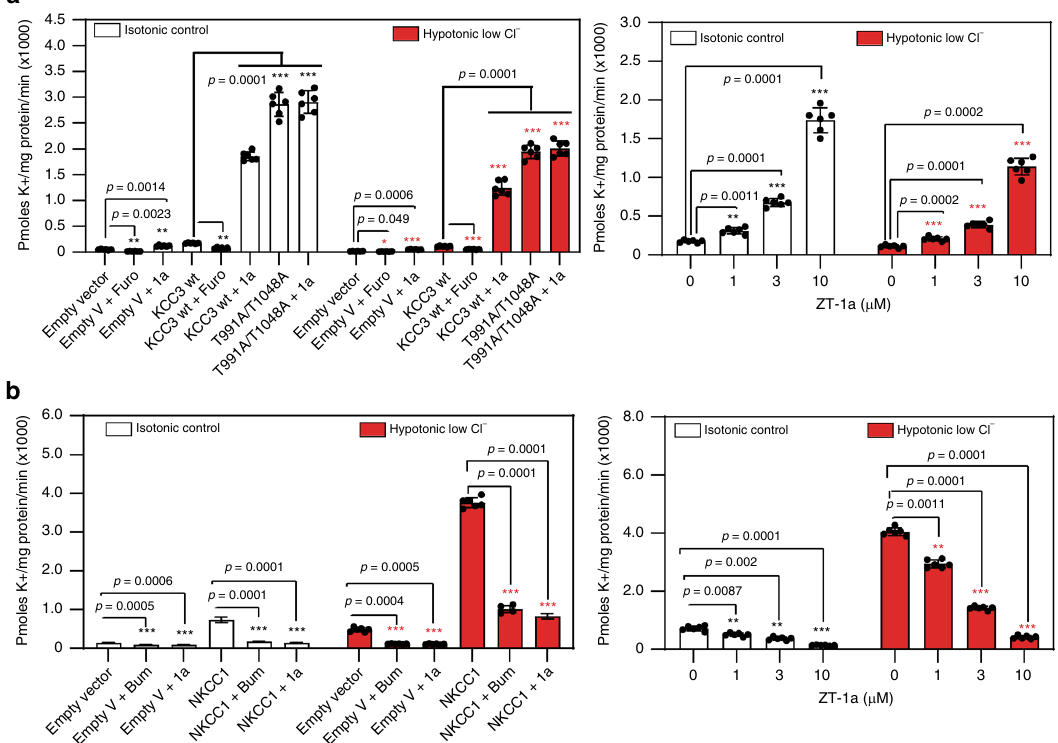
Fig. 3 ZT-1a inhibition of SPAK kinase correlates with CCC activity. a 86 Rb + uptake assays in the presence of ZT-1a measure transport activity of KCC3A. ( a — left panel) HEK-293 cells were transfected with constructs encoding the indicated WT or mutant constructs of N-terminally FLAG-tagged KCC3. Thirty-six hours post transfection, cells were exposed for 30 min to either control isotonic conditions or hypotonic low [Cl − ] conditions (to activate the SPAK/OSR1 pathway), and then treated in the same conditions for an additional 30 min with 10 µ M ZT-1a or 1 mM furosemide (Furo) in the presence of 1 mM ouabain (Na + /K + -ATPase inhibitor) and 0.1 mM bumetanide (NKCC1 inhibitor). 86 Rb + uptake was allowed to proceed for 10 min and was then quanti fi ed by scintillation counting. 86 Rb + uptake counts per minute (CPM)s were normalized per mg protein and plotted for both isotonic and hypotonic conditions. ( a — right panel) HEK-293 cells were transfected with constructs encoding wild-type N-terminally FLAG epitope-tagged KCC3A. Thirty-six hours post transfection, cells were exposed for 30 min to either control isotonic conditions or hypotonic low [Cl − ] conditions (to activate the SPAK/OSR1 pathway), and then treated for an additional 30 min in the same conditions with the indicated ZT-1a concentrations in the presence of 1 mM ouabain